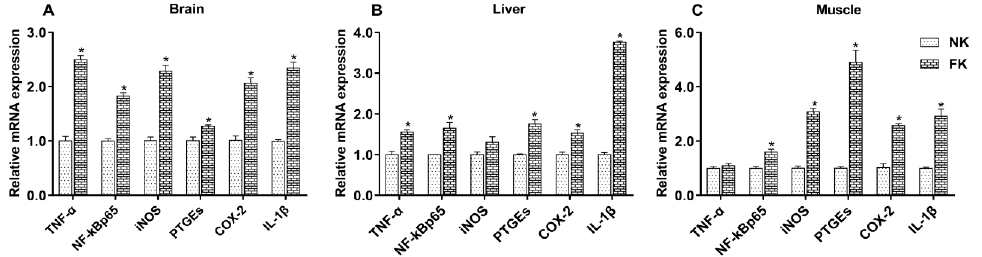
Figure 4. Expression levels of TNF-α , NF-κBp65 , iNOS , PTGEs , COX-2 , and IL-1β mRNA in the brains ( A ), livers ( B ), and muscles ( C ) of laying hens with normal keel (NK) or fractured keel (FK). * p ≤ 0.05. Protein expression levels of COX-2, NF-κBp65, and iNOS in the livers and brains are shown in Figure 5. The protein levels of COX-2 and iNOS in the livers, and COX-2, NF-κBp65 and iNOS in the brains of FK hens significantly increased ( p < 0.05). However, there was no difference ( p > 0.05) in NF-κBp65 in the livers of FK hens compared to NK hens.